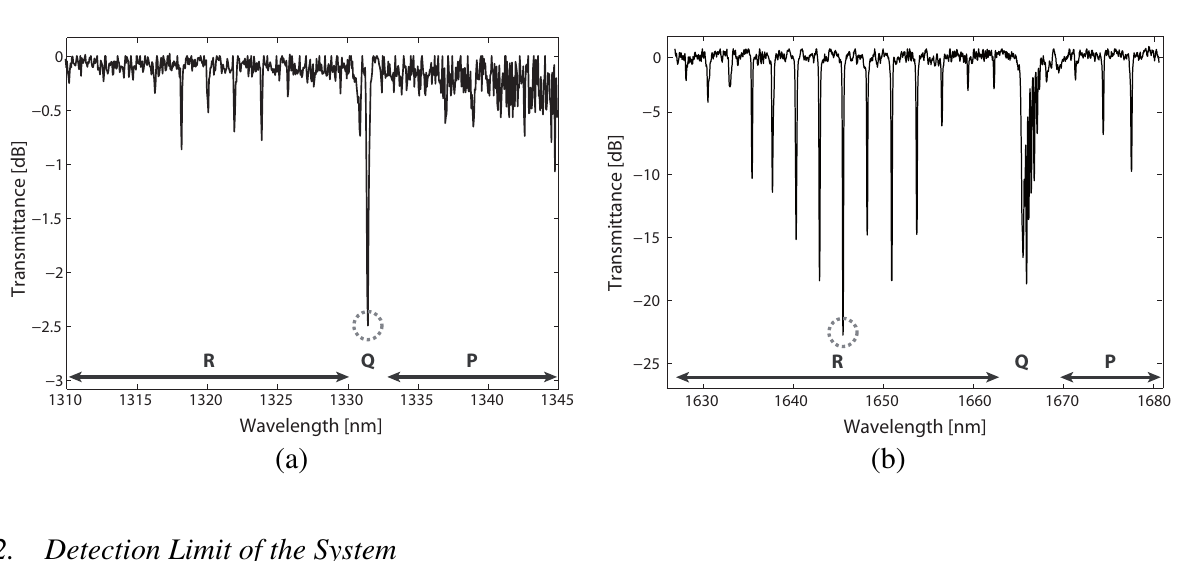
band, measured with the HC1600 fibre. R, P and Q branches 3